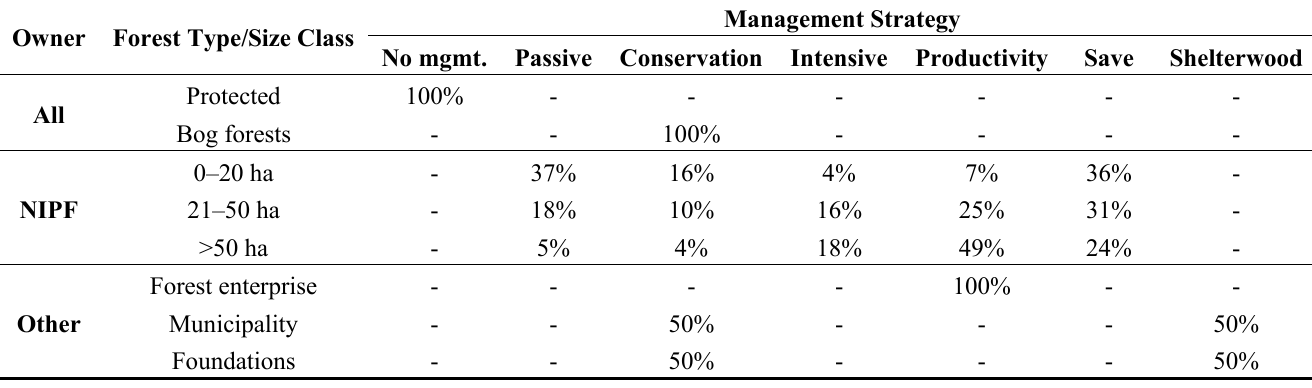
Table 4. Distribution of management strategies for the different owner and forest types in the Diverse scenario